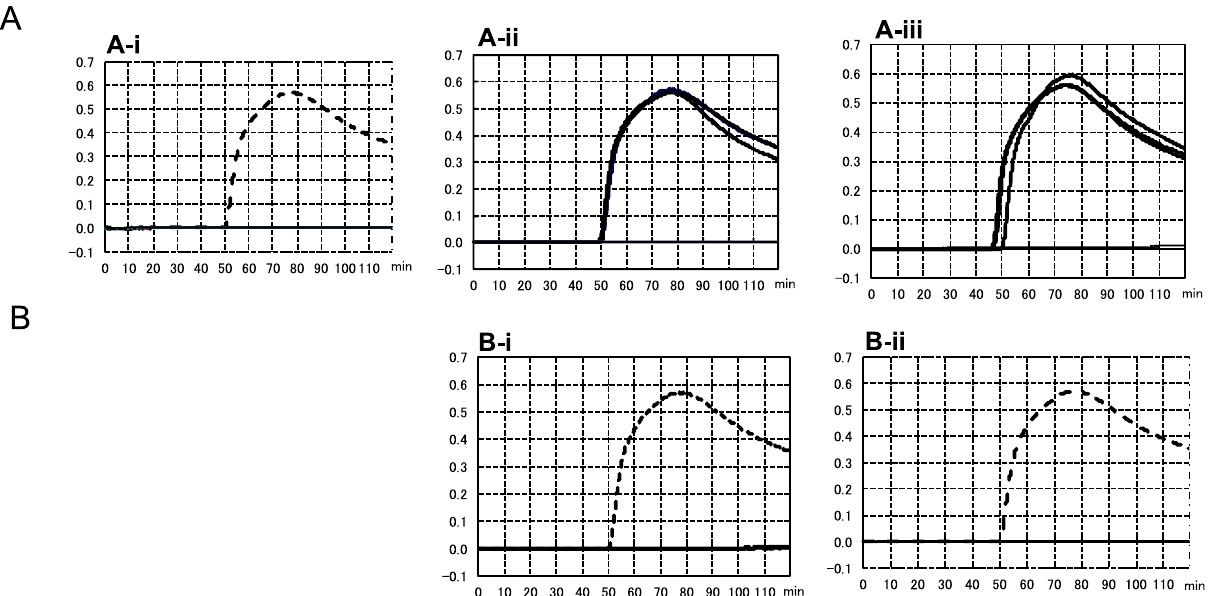
Figure 4. Comparative amplification profiles of A. fumigatus wild type and environmental or clinical azole- resistant isolates with or without TR46 double or triple 46 bp promoter repeats in cyp51A gene by a newly developed LAMP primer sets. The dotted curve shows the amplification by control strain (IFM 63432). ( A - i ) DNA amplification profiles using 30 strains of A. fumigatus wild type. DNA amplification was not confirmed in all wild-type strains tested (30 strains). Among 30 wild-type strains, IFM 62918 strain was used as a negative control strain (no amplification). ( A-ii ) DNA amplification was confirmed by five TR 46 2 strains (IFM63432, BE1-2, BE1-4, BE3-5, BE3-6), which have double 46 bp promoter repeats. ( A-iii ) DNA amplification was confirmed by three TR 46 3 strains (BE1-1, W1-4, W2-12-1), which have triple 46 bp promoter repeats. ( B-i ) DNA amplification was not confirmed by two TR 34 2 strains (IFM64460, IFM64733), which have duplicate 34 bp promoter repeats with one mutation in the one coding region (L98H). The dotted line shows amplification by the control strain. ( B-ii ) DNA amplification was not confirmed by one TR 34 2 strain (3-1-B), which has duplicate 34 bp promoter repeats with multi-mutations in the four coding regions (L98H/T289A/I364V/G448S). The dotted line shows amplification by the control strain.